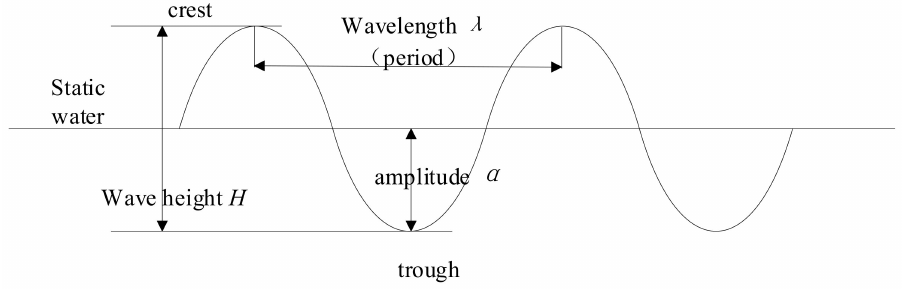
Figure 1. Vibration of a seawater